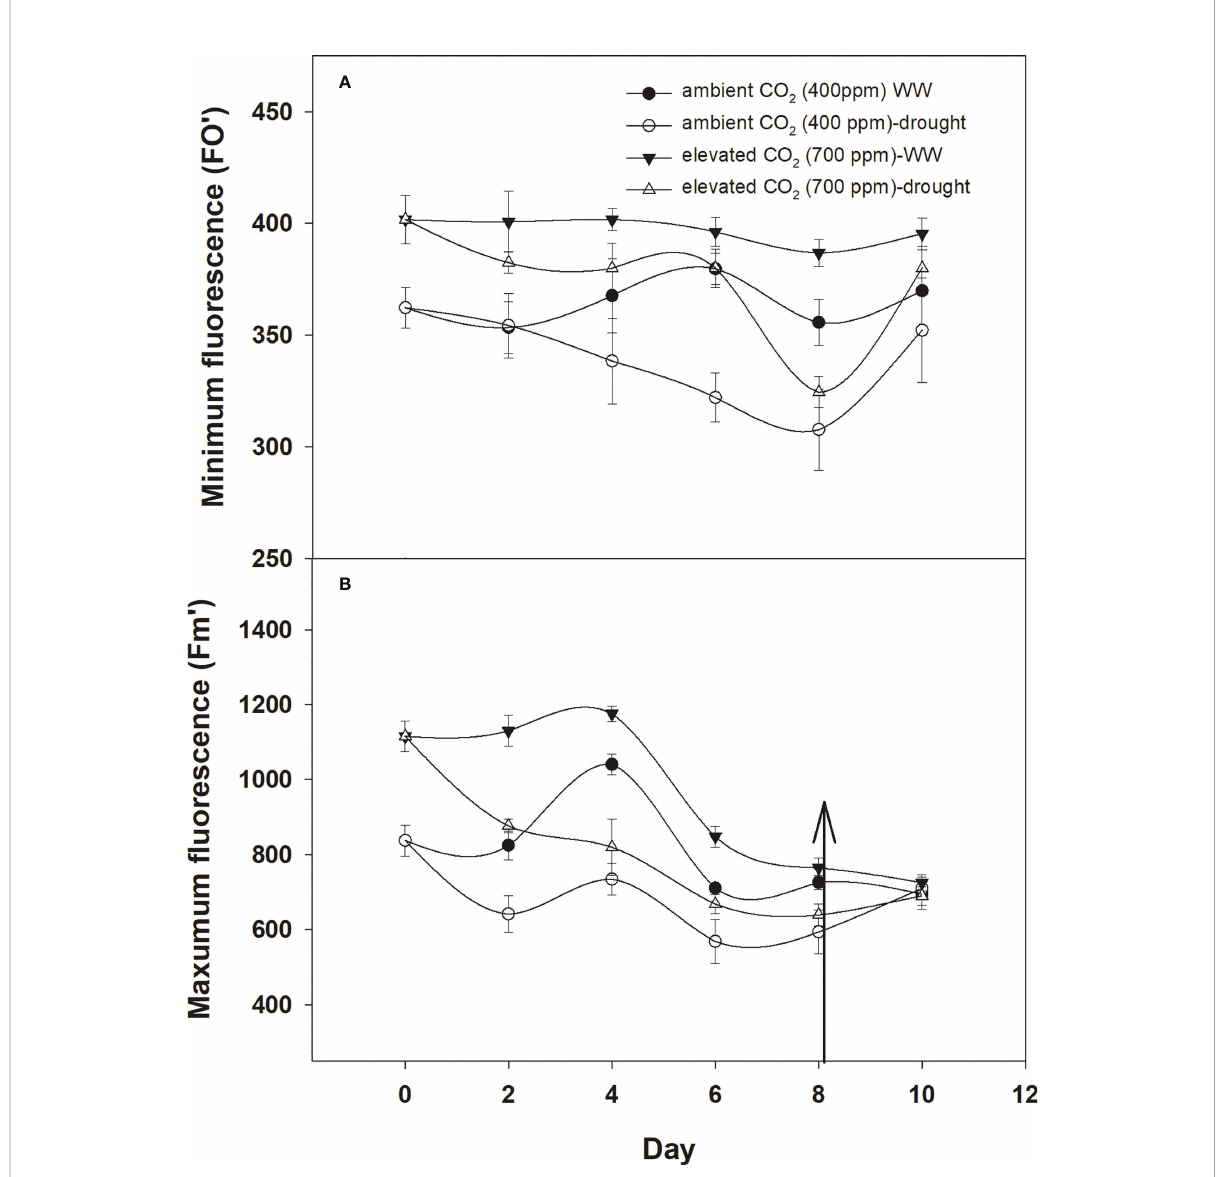
FIGURE 6 Effect of CO 2 concentrations and moisture conditions on (A) minimum fl uorescence and (B) maximum fl uorescence of Datura stramonium . The vertical line on the data point represents the standard error of the mean and the vertical arrow line after Day 8 represents the addition of water in the drought treatments. WW,